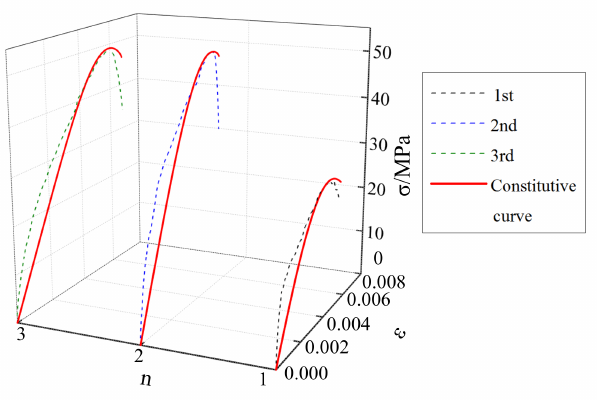
Figure 15. Comparison between the 0.20 MPa-pressure cyclic-impact test results and the theoretical results for